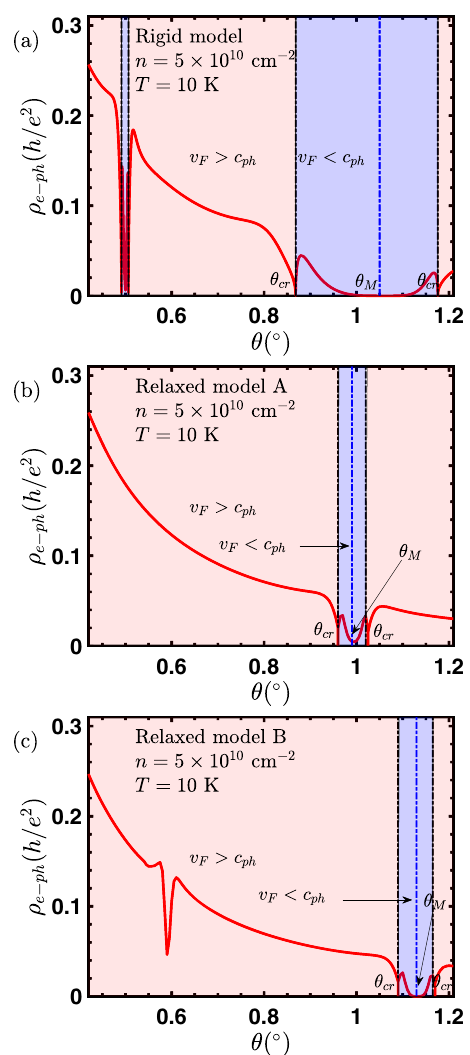
Fig. 4 Close to the magic angle, the electron – phonon resistivity in tBG is very sensitive to the twist angle exhibiting a variation of several orders of magnitude when v F = c ph and unrelated to Mott insulation or superconductivity. The number of these sharp dips in resistivity and the angles at which they occur provide information about lattice relaxation 13